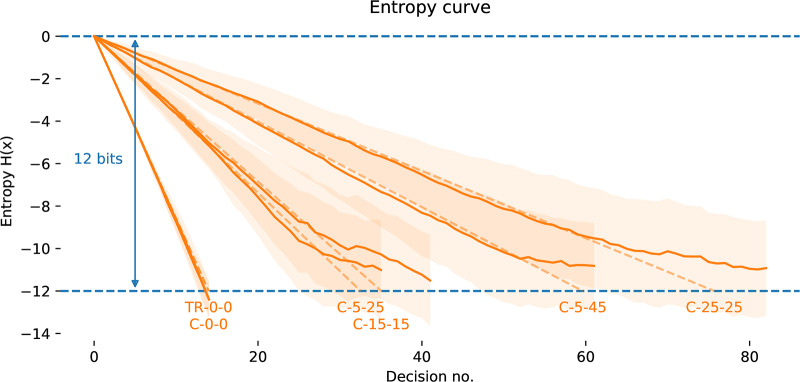
Mean entropy time series.Each plot shows the mean (solid line), one standard deviation (shaded area) and the theoretical prediction (dashed line) of the entropy of the decoder’s PDF against decision number, for each of the experimental conditions.